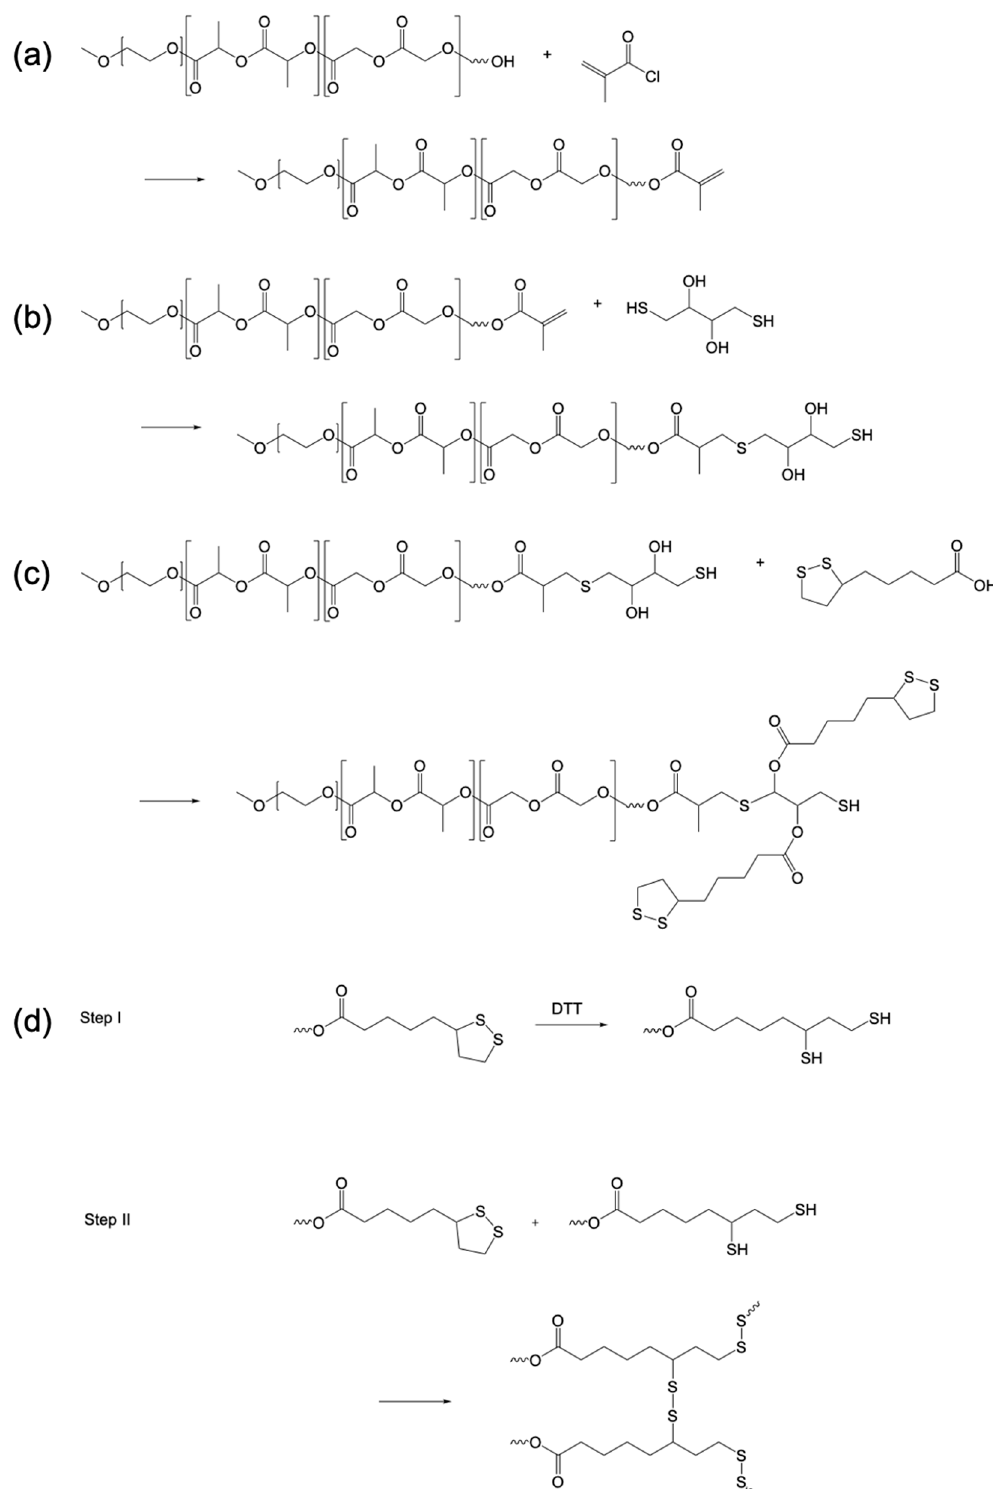
Figure 1 . Chemical scheme of reversed micelles synthesis: ( a ) modification of the commercial mPEG- b -PLGA –OH terminated copolymer to obtain product 2 ; ( b ) modification of product 2 by adding a terminal DTT unit to obtain the product 3 ; ( c ) modification of the product 3 by adding two lipoic acid units per copolymer molecule to obtain the product 4 ; ( d ) intermolecular crosslinking reaction to obtain the stabilized structure of the reversed micelles, Step I: reduction of a few LA units by DTT, Step II: reduction of LA units by –SH on the copolymer molecules.